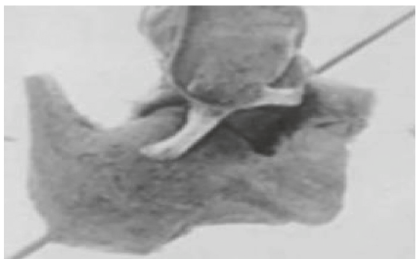
Figure 1: Plantar flexor muscle